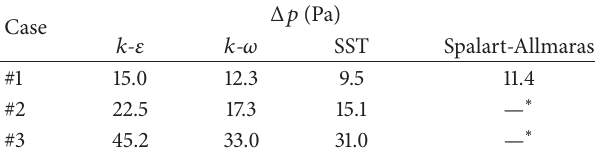
Figure 9: Grid system for the benchmark validation. Table 5: Sensitivity to the turbulence models, 2D (COMSOL).